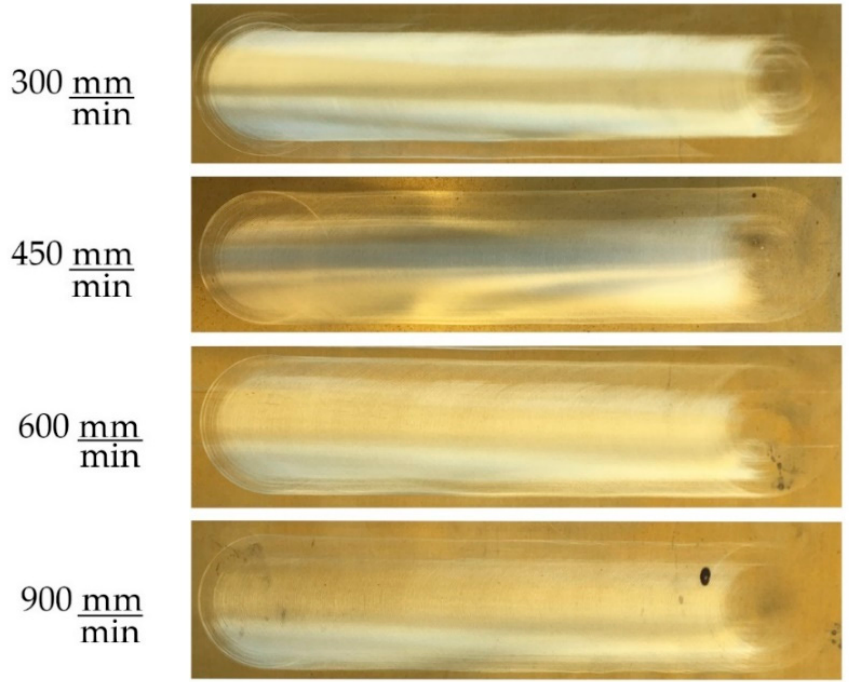
Figure 9. Results for cut feed variation on brass.